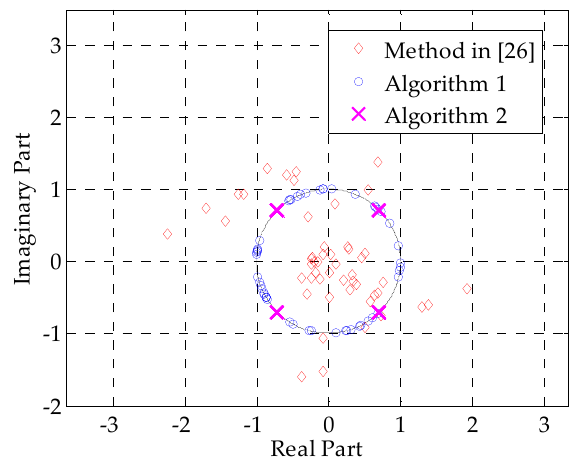
Figure 7. Real and imaginary parts of different methods’ results.